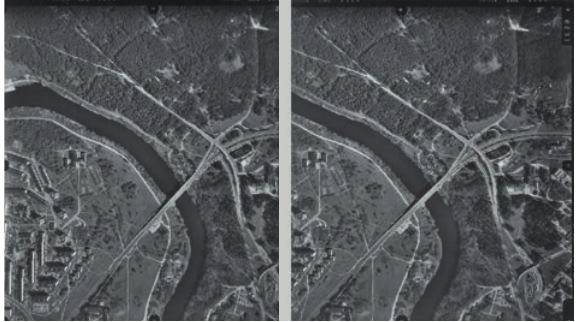
Fig. 3. Scanned aerial photograph: the left and right part of the image